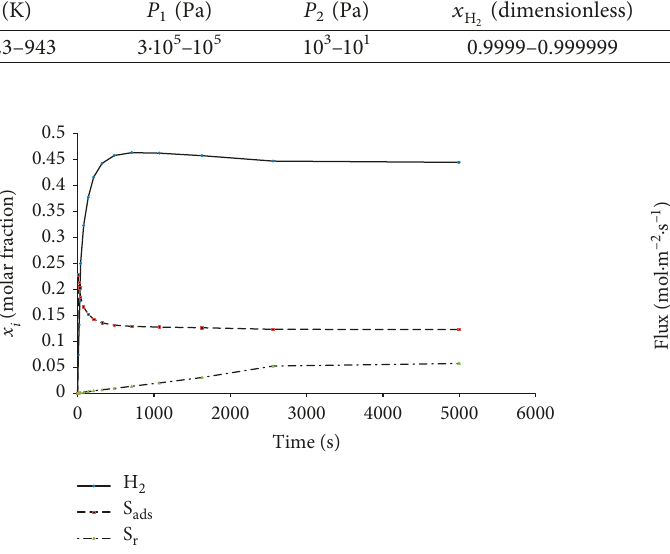
Figure 8: Fractions of adsorbed species on the high-pressure side of the